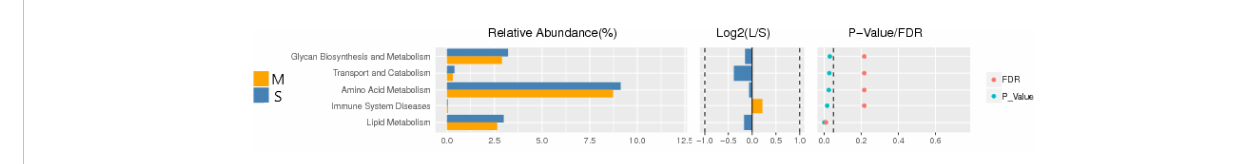
FIGURE 6 Diagram of the difference in the Keeg Path Wilcox Test between the two